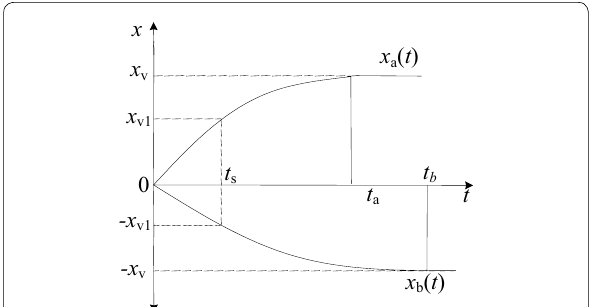
Figure 2 Quick response mechanism of the two-push-rods electromechanical converter